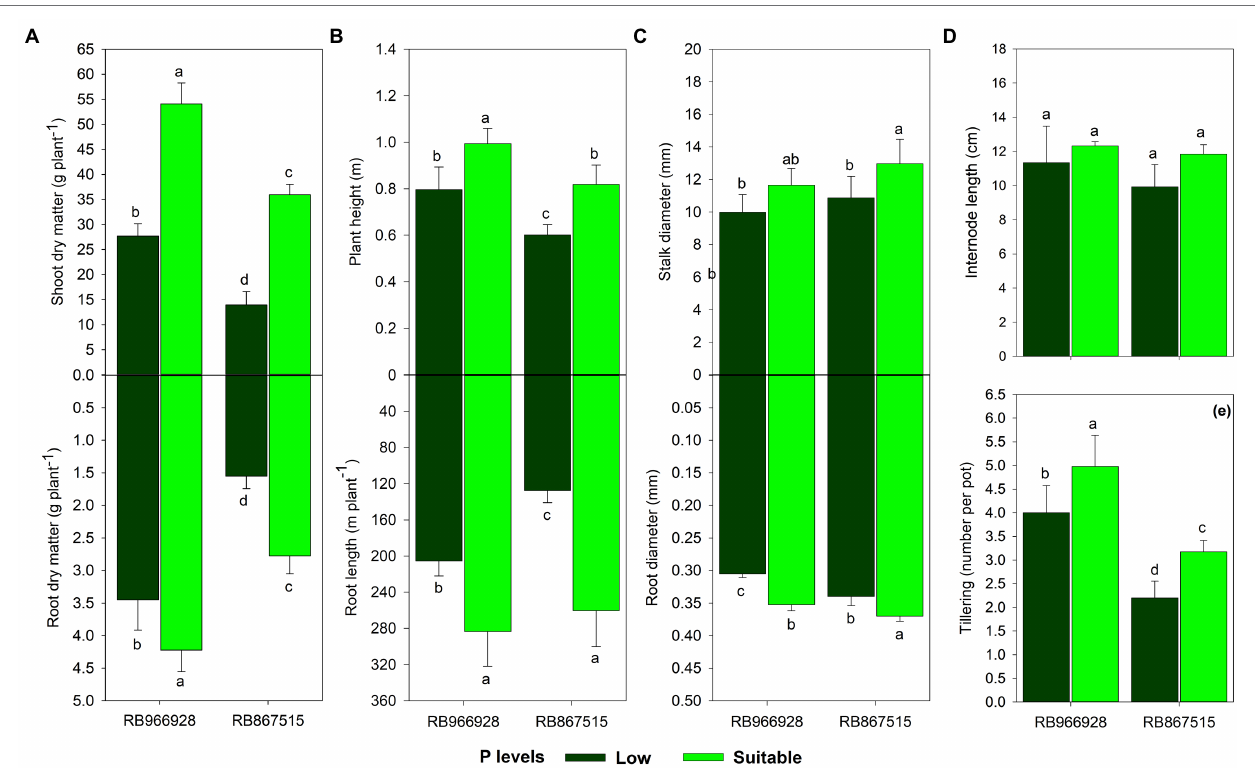
FIGURE 4 | Biometrics of (A) root and shoot dry matter, (B) root length and plant height, (C) root and stalk diameter, (D) internode length, and (E) tillering as a function of sugarcane RB966928 and RB867515 varieties and low and suitable P levels. Different lower-case letters indicate significant differences in sugarcane variety and P level interaction by Student’s t -test at p ≤ 0.05. The error bars express the SE of the mean ( n =